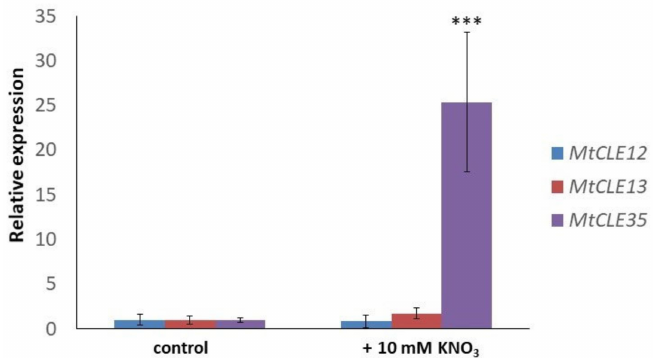
Figure 3. The expression levels of MtCLE12, MtCLE13, and MtCLE35 in response to nitrate treatment (10 mM KNO 3 ). Asterisks indicate statistically significant di ff erences in MtCLE35 expression compared with control ( p <